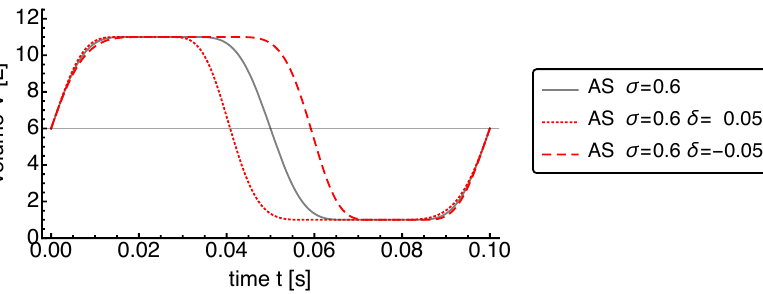
Figure 2. Plot of the cylinder volume over time V ( t ) for the “adjustable sinusoidal motion” AS for = 0.1s with δ = 0 and σ = 0.6 (solid line) in comparison to the AS motion with δ = − 0.05 t 0 and σ = 0.6 (dashed line) and with δ = 0.05 and σ = 0.6 (dotted line). Within a period of motion, negative values of δ reduce the time the volume spends around its maximum and increase the time it spends around its minimum. Positive values lead to the opposite